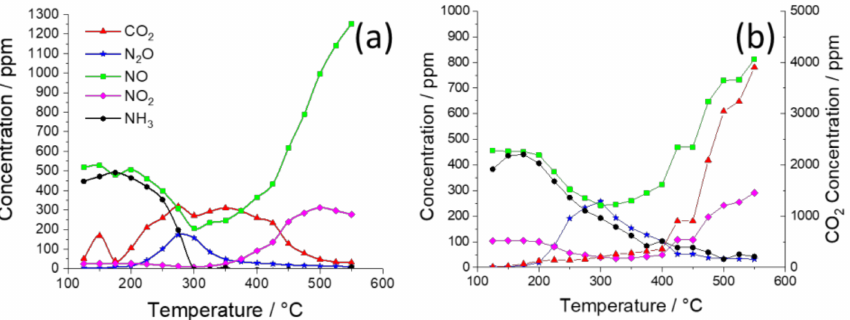
Figure 10. Performance of 2%Ag–2%K/CZA tested in a simulated exhaust gas containing NH 3 as reductant ( a ) in the absence of carbon black, and ( b ) in the presence of carbon black. Again, in common with the catalysts containing 5, 10 and 15 wt% K, the dominant route to CO 2 over 2%Ag–2%K/CZA was via the C+O 2 reaction, with an onset temperature of 375 ◦ C. This was 150 ◦ C lower than the onset temperature for the C+O 2 reaction over K-free Ag/CZA, but it still lies just outside the upper limit of the typical temperature window for diesel exhaust emitted by the engine of a passenger car (see Figures 1 and